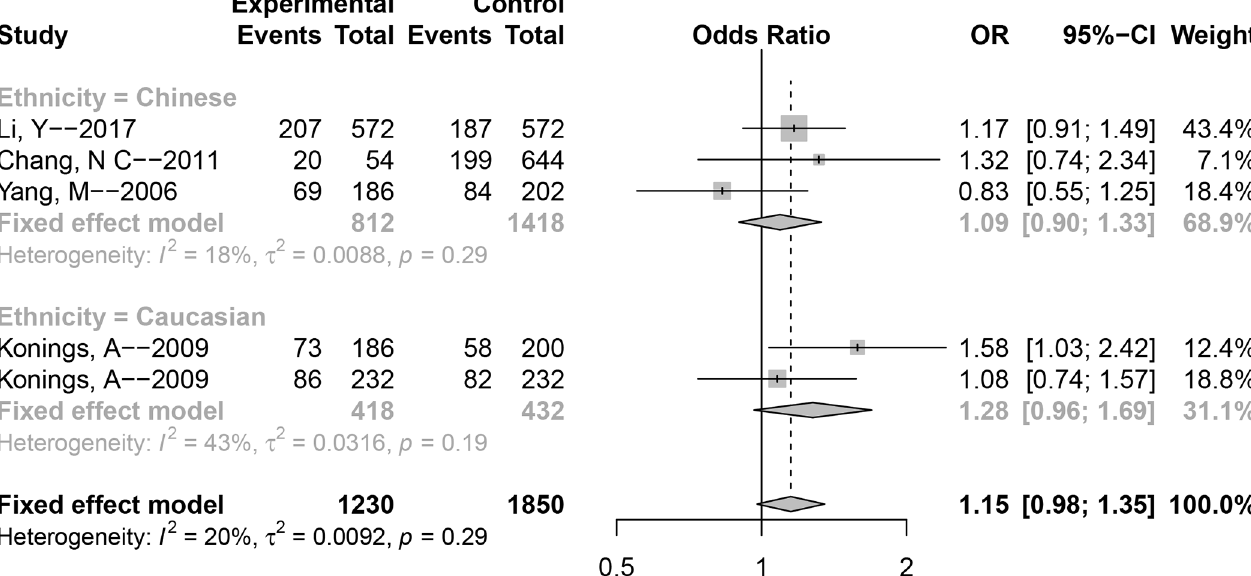
Fig 2. Forest plot of the association between polymorphism rs1043618 and noise-induced hearing loss (NIHL) (Allele model: C versus G).